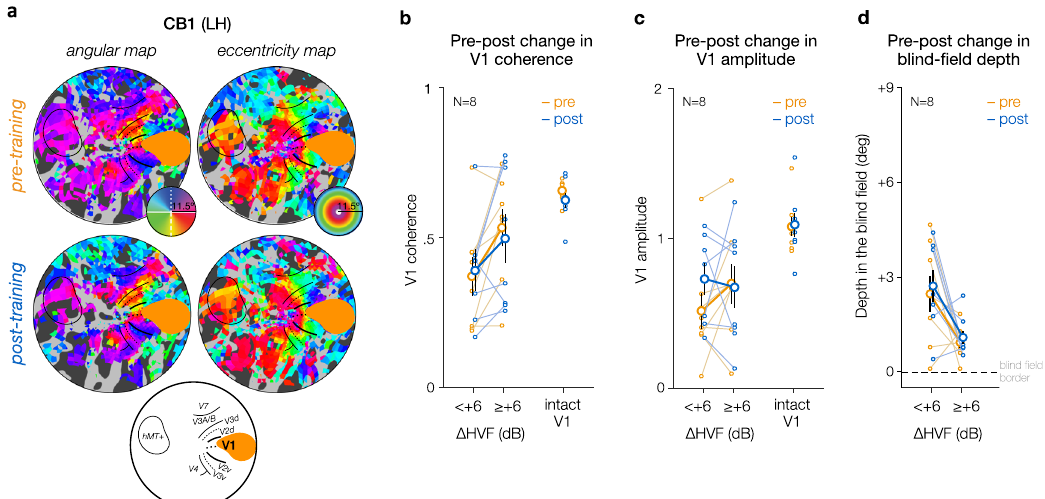
Fig. 5 Retinotopic organization and V1 activity in CB patients ( N = 8) following training. a Sample pre-training and post-training retinotopic maps of the damaged hemispheres for one of our CB patients (see Supplementary Fig. S4 for all individual post-training maps). Qualitatively, no global change in retinotopic organization was observed following training. V1 response ( b : coherence; c : amplitude) for voxels representing blind- fi eld locations prior to training, are then plotted as a function of training and post-training HVF recovery. Although no consistent change in V1 coherence was observed following training, V1 voxels representing blind- fi eld locations with weak HVF recovery showed increased response amplitude. Data were split based on the level of HVF recovery for illustration purposes only (no recovery: Δ HVF < + 6 dB; signi fi cant recovery: Δ HVF ≥ + 6 dB), while generalized linear mixed-effects models on unbinned data, with participants as a random effect, were used for statistical analyses. Solid symbols represent group-averaged values with ±1SEM error bars, with each individual CB patient represented by thinner lines. d Same as ( b , c ) but for the depth in the blind fi eld of the preferred position of V1 voxels before and following training as a function of the amount of HVF recovery observed at that blind- fi eld location.